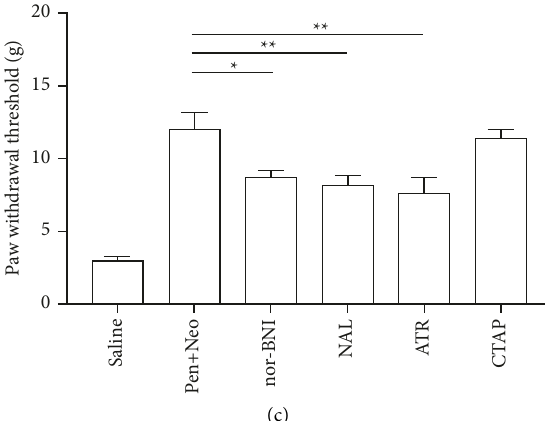
Figure 5: To evaluate the possible interaction mechanism between pentazocine and neostigmine, nor-Binaltorphimine (nor-BNI, 10 μ g), CTAP (10 μ g), naloxone (NAL10 μ g), and atropine (ATR 10 μ g), were intrathecally administered 30 minutes before the administration of the pentazocine (30 μ g)-neostigmine (3.0 μ g) mixture. (a) Nor-BNI, naloxone, and atropine significantly antagonized the antinociception of the pen-neo mixture in the first phase of formalin pain (One-way ANOVA, F 5,54 � 36.437, P < 0 . 001). (b) Nor-BNI, naloxone, and atropine significantly antagonized the antinociception of the pen-neo mixture in the second phase of formalin pain (One-way ANOVA, F 5,54 � 62.32, P < 0 . 001). (c) Nor-BNI, naloxone, and atropine significantly antagonized the antinociception of the pen-neo mixture in the plantar incision pain model (One-way ANOVA, F 5,54 � 16.88, P < 0 . 001). ∗ P < 0 . 05, ∗∗ P < 0 . 01, ∗∗∗ P < 0 . 001 vs. Pen+Neo group, n � 10 rats in each group. Each bar represents the sum of flinches in (a) phase (I), (b) phase II, and (c) the mechanical withdrawal threshold (mean ± SEM) from 10